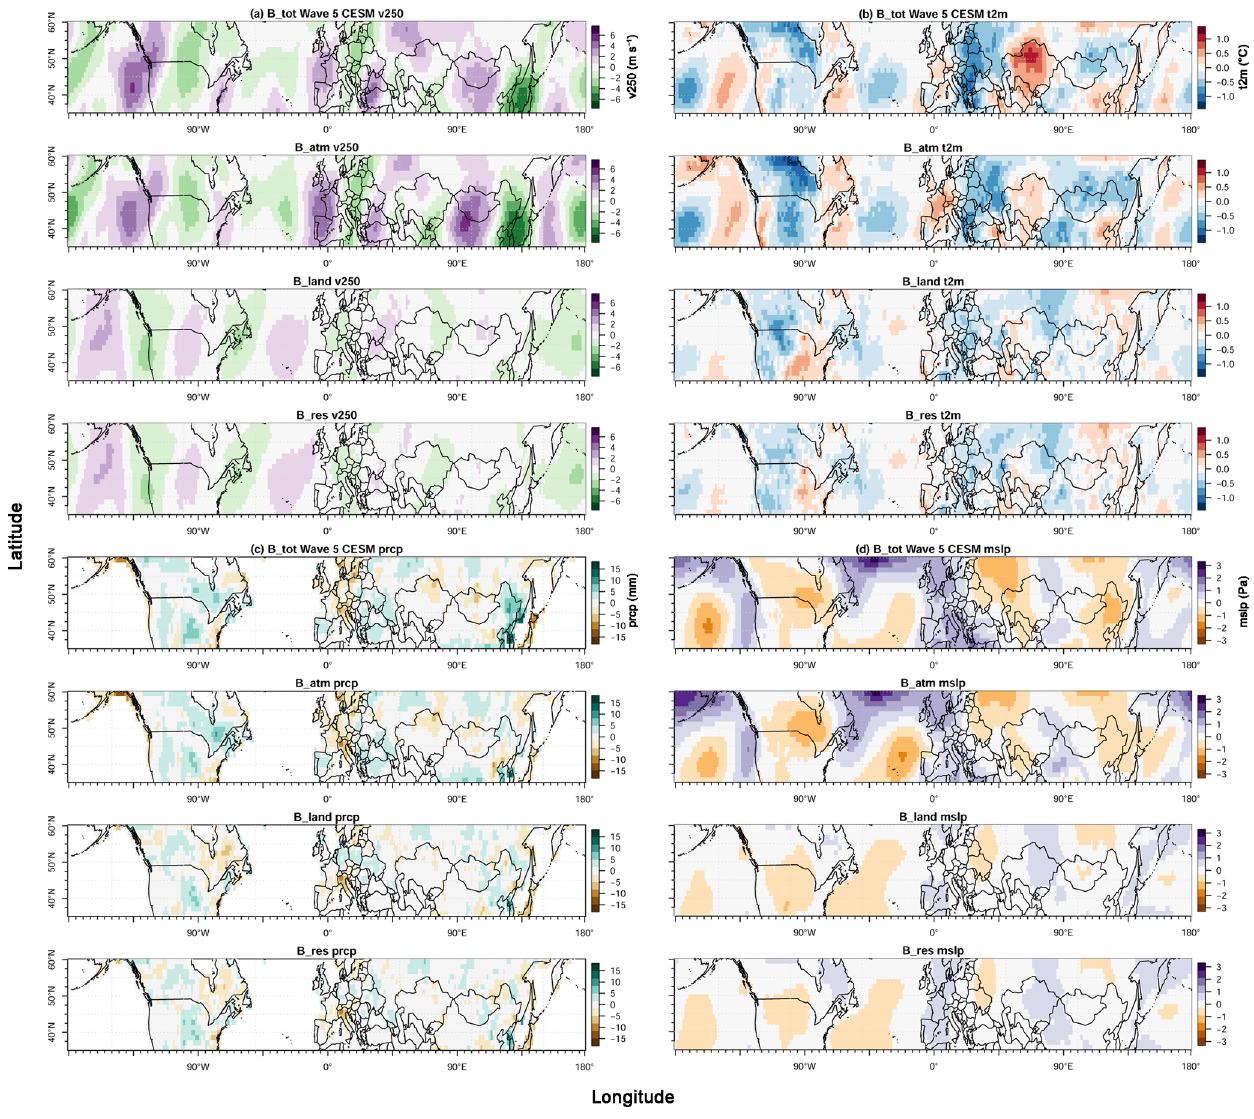
Figure B6. Bias plots for high-amplitude wave-5 events and episodes in different experiments for CESM. Total bias (B_tot), atmospheric bias (B_atm), land–atmosphere interaction bias (B_land), and residual bias (B_res) for meridional wind velocity at 250hPa (a) , surface temperature (b) , precipitation (c) , and sea level pressure (d)